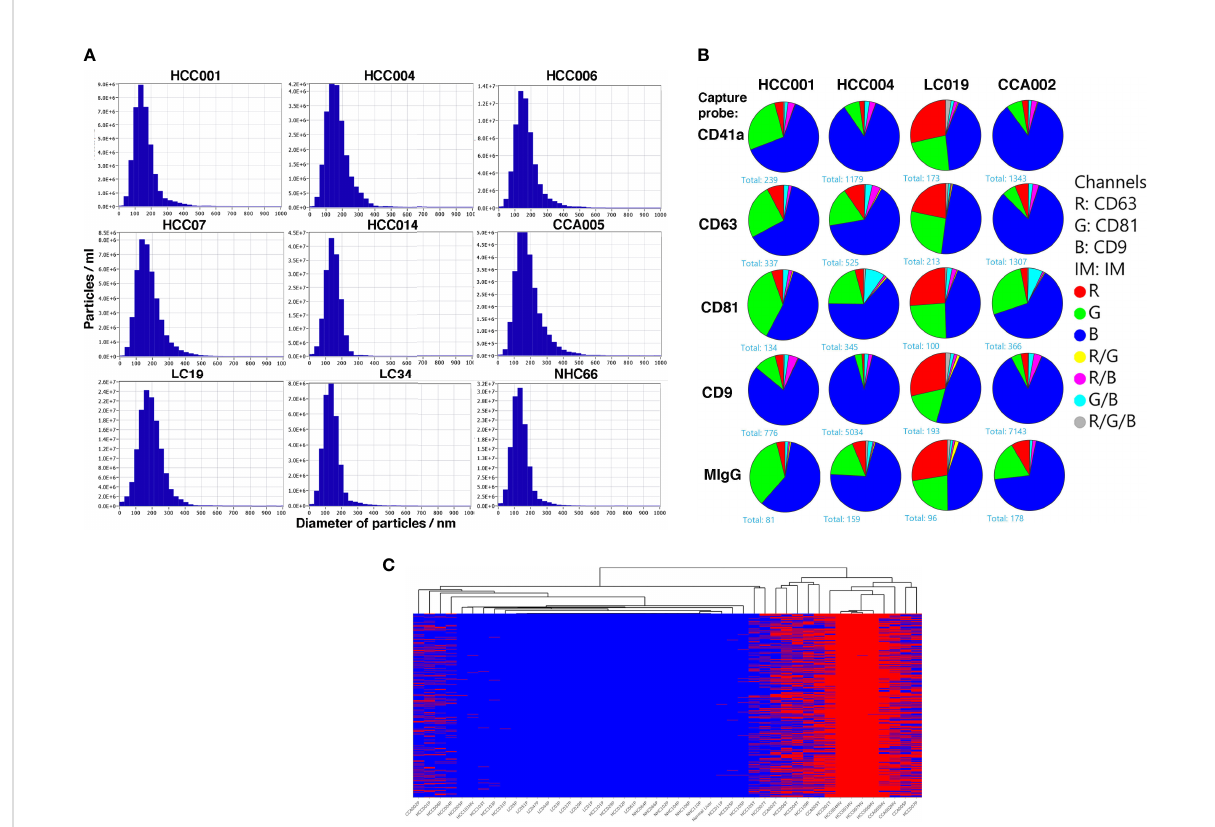
FIGURE 5 Characterization of extracellular vesicles isolated from the plasma and pro fi les of high-risk tumor speci fi c mRNA variants within the EVs of HCC patients. (A) . Plasma samples from HCC patients, LC patients without HCC and normal healthy controls were spun to remove the cellular debris before precipitation of EVs using ExoQuick kit followed by ultracentrifugation. followed by NanoSight tracking and Chip analysis. Dilutions of samples with PBS were carried out as shown in methods followed by Zetaview NTA analysis. 11 positions/frames were used to analyze each sample. Y-axes represent particles/ml and x-axes represent particle diameter in nm. The highest value on y axes re fl ects the number of particles/ml at the peak. (B) Exoview chip analysis was carried out to evaluate tetraspanin receptor expression. EVs stained for CD63, CD81 and CD19 antibodies and anti CD41a and mIgG used as controls. Data is represented as pie charts to re fl ect the tetraspanin receptor pro fi les in EVs from two HCC, 1 LC and 1 CCA patients. LC patient derived EVs seem to have a higher expression of CD63 compared to HCC or CCA patients. (C) Heat map representing occurrence (red color) of 1,369 high-risk variants identi fi ed in EVs of HCC patients but not in LC and NHC controls, with clustering dendrogram of samples on the top. Most of the EV samples are clustered on the right side, along with RNA from cancer patients (tissue and plasma). Annotation of variants is shown in Supplementary Table